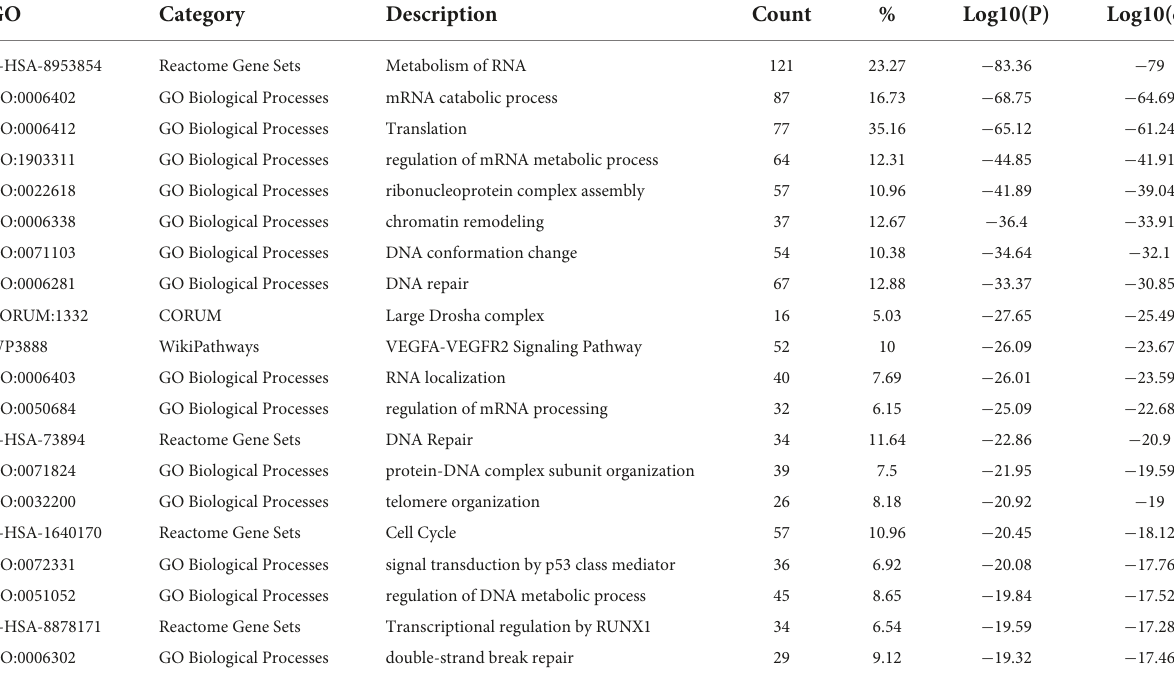
Count = total number of proteins from the 5 cell lines proteomics list that are included in the corresponding onthology term; % = percentage of proteins from the 5 cell lines proteomics list that are found in the corresponding onthology term; Log10(P) = p-value in Log base 10; Log10(q) = multiple test adjusted p-value in Log base 10 by using the Banjamini-Hochbergprocedure.